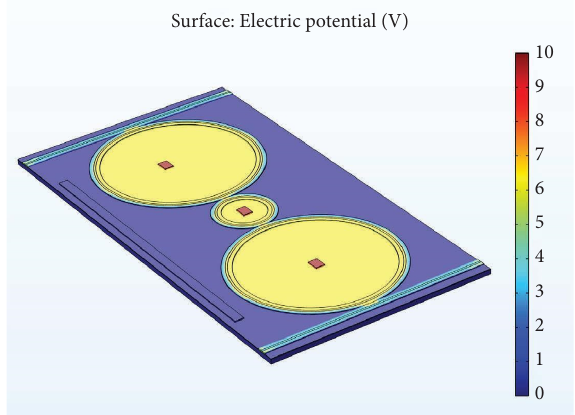
Figure 11: 3D view of the voltage distribution in TiN CMOS-compatible electrodes. Te uniform distribution of the electric potential ensures a synchronous tuning of individual resonances in